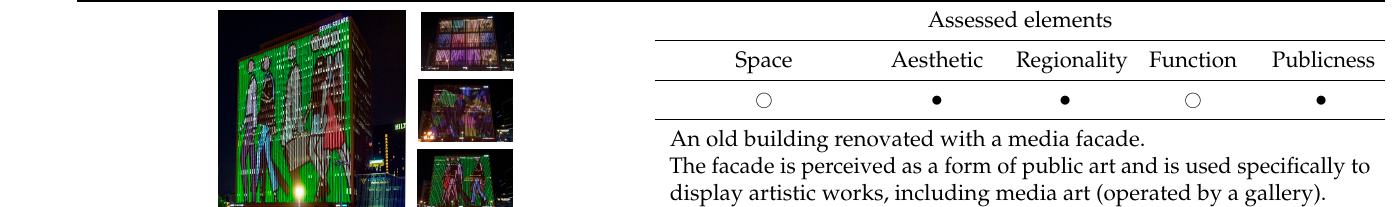
Table 6. Media facades: Seoul Square (Junglim Architecture/iArc 2009).